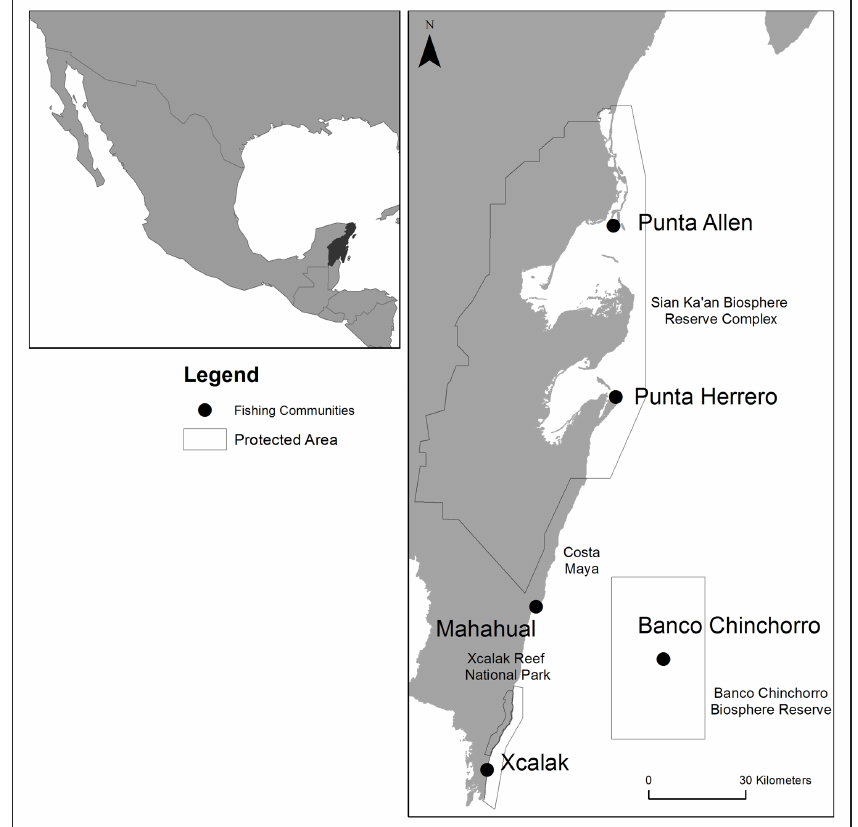
Figure 1: Map of the study